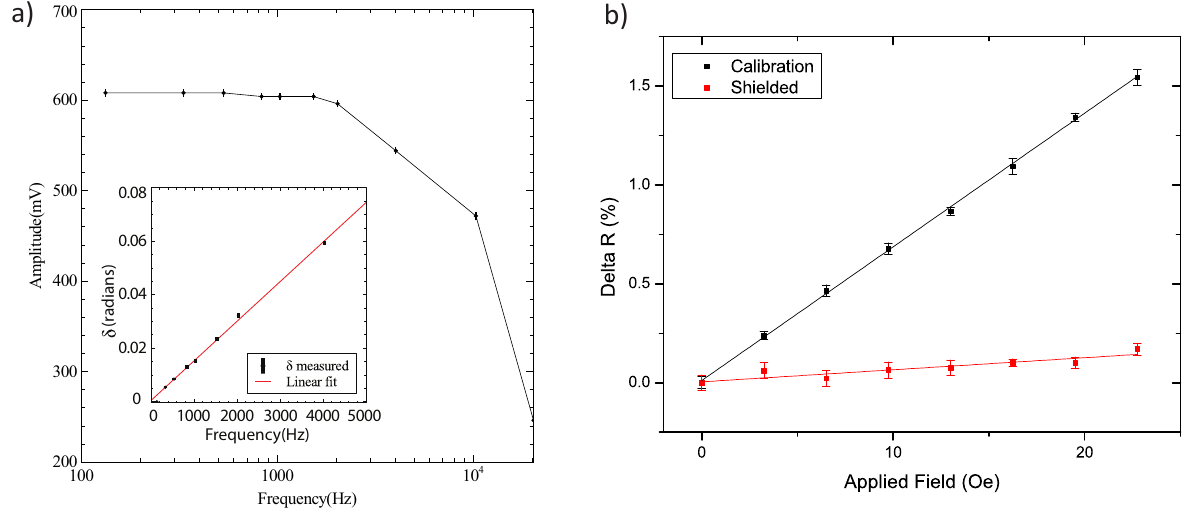
Figure 4. ( a ) The peak-peak voltage signal observed when measuring the reference through our pre-amplifier. The reference impedance was 20.1 k Ω and the current was ± 1.5 µ A. The inset shows the phase difference between the reference and sensor signals as a function of frequency; ( b ) The percentage change in resistance, ∆ R (%), due to an in-plane field is shown in black. The data in red show the same measurement after a sheet of mu-metal is added in between the glass cartridge and the scanner